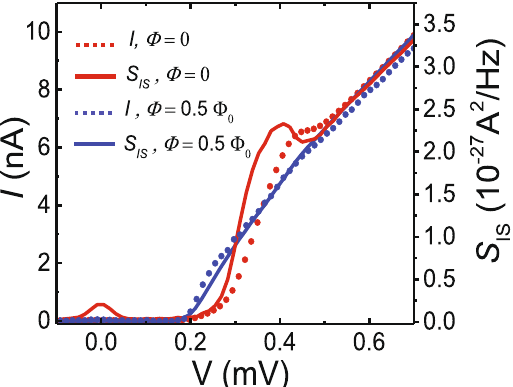
Figure 4. Bias dependence of the current noise. IV characteristics of the SQUIPT (red and blue dots) compared to the measured current noise S (red and blue solid lines) vs. bias voltage, at the two extreme flux values, Φ = 0 I S and Φ = 0.5 Φ 0 .